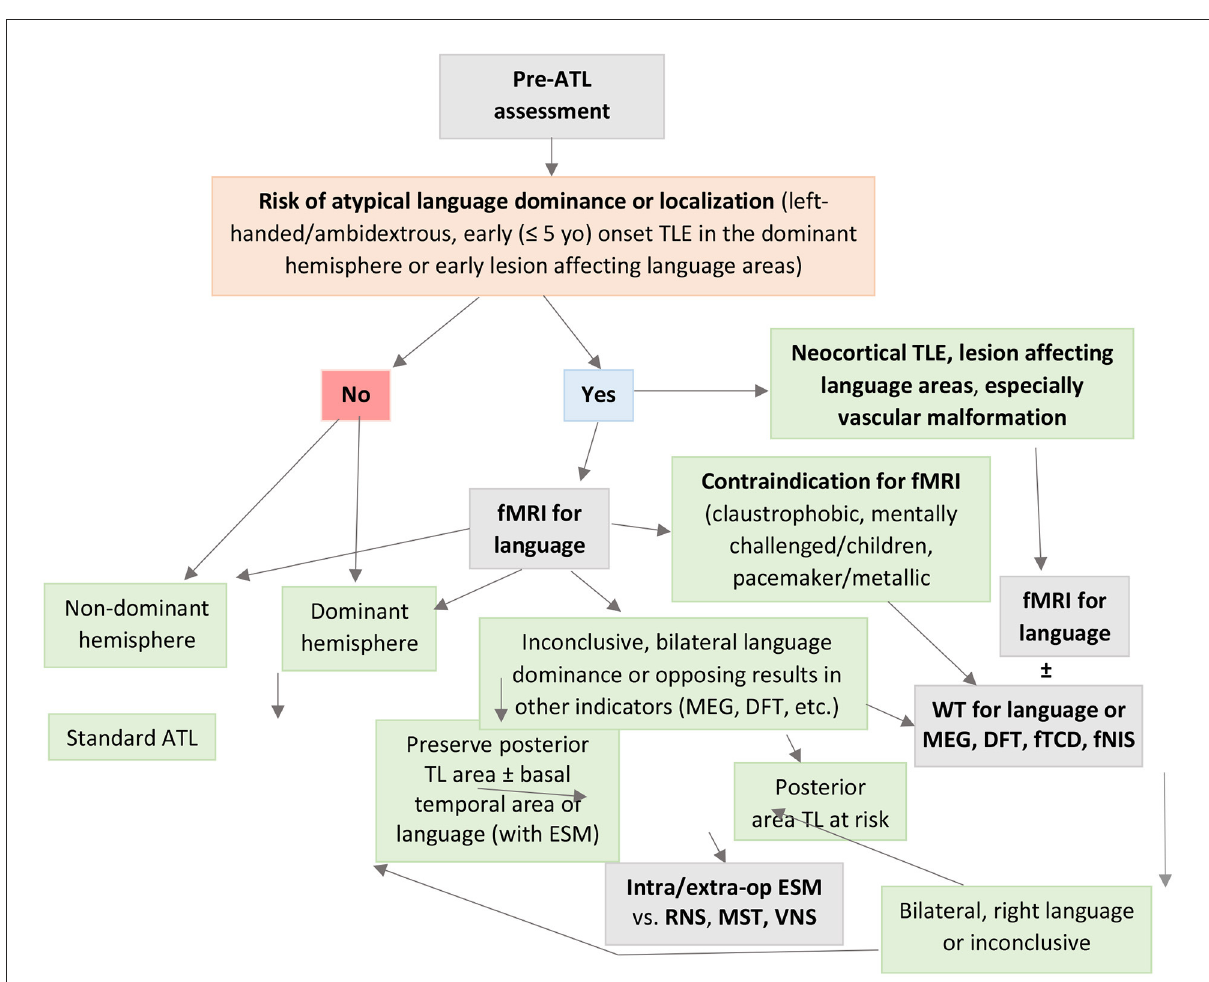
FIGURE3 Flowchart to guide clinical decision-making when using fMRI and WT for presurgical evaluation of language in TLE. ATL, anterior temporal lobectomy; DFT, dichotic fused word listening test; Fmri, functional magnetic resonance imaging; Fnis, functional near-infrared spectroscopy; Ftcd, functional transcranial doppler sonography; Intra/extra-op ESM, Intra/extra-operative electrocortical stimulation mapping; MEG, magnetoencephalography; MST, multiple subpial transections; RNS, responsive neurostimulation; TLE, temporal lobe epilepsy; VNS, vagus nerve stimulation; WT, wada